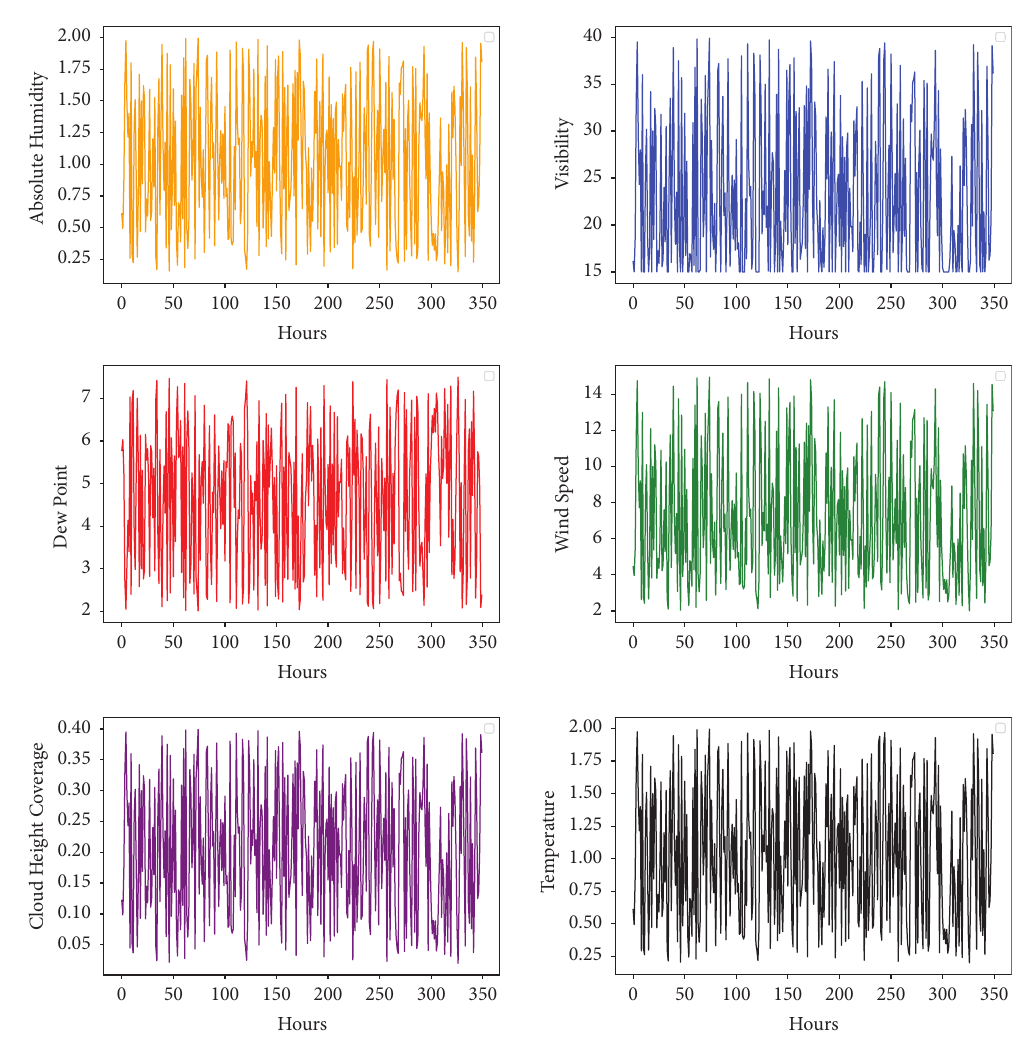
Figure 5: Descriptive diagram of meteorological